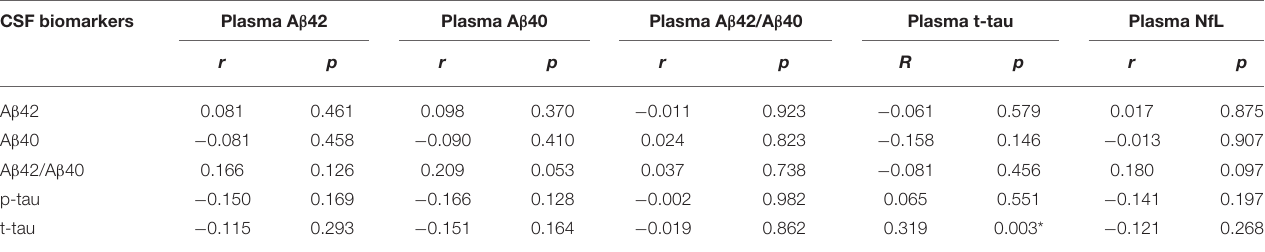
TABLE 3 | Correlations between plasma biomarkers and CSF biomarkers in patients with AD ( n =